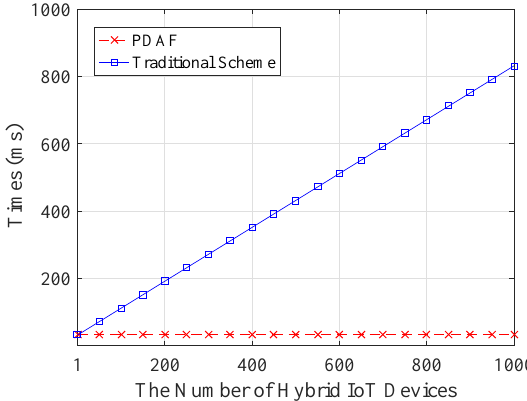
Figure 3. The computation cost